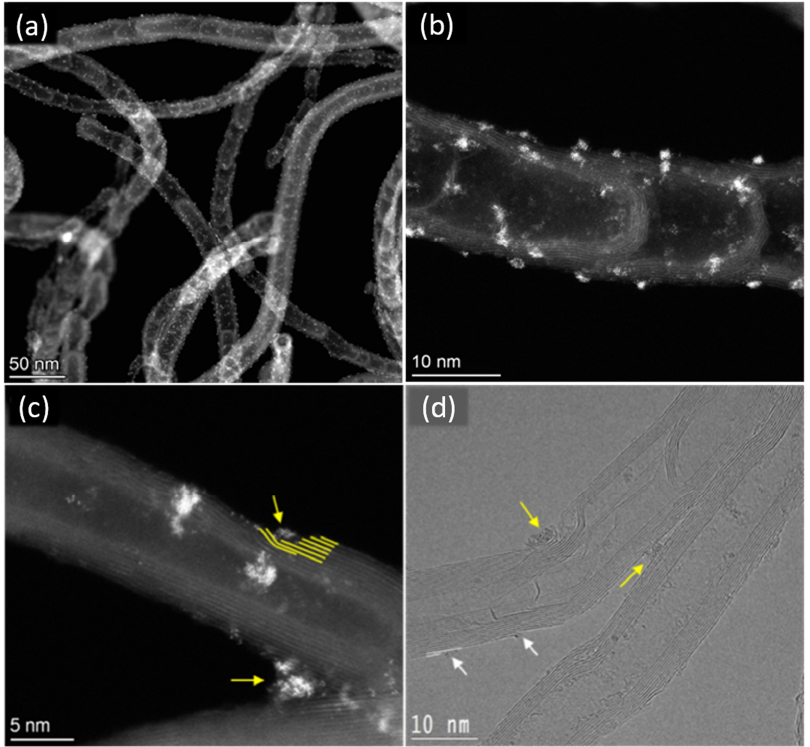
Figure 6. HAADF-STEM ( a – c ) and HRTEM ( d ) images of 8 wt. % NbW 5 /N-CNTs 4.8 at. % N ( a , b ) and 8 wt. % NbW 5 /CNTs ( c , d ). White arrows indicate a single POM species located near defects–cut-off edges of graphene layers exposed to the surface. Yellow arrows indicate POM agglomerates located on extended defects of CNTs surface and in the cavities between nanotubes. Reproduced from Ref. [103] with permission from the Royal Society of Chemistry.